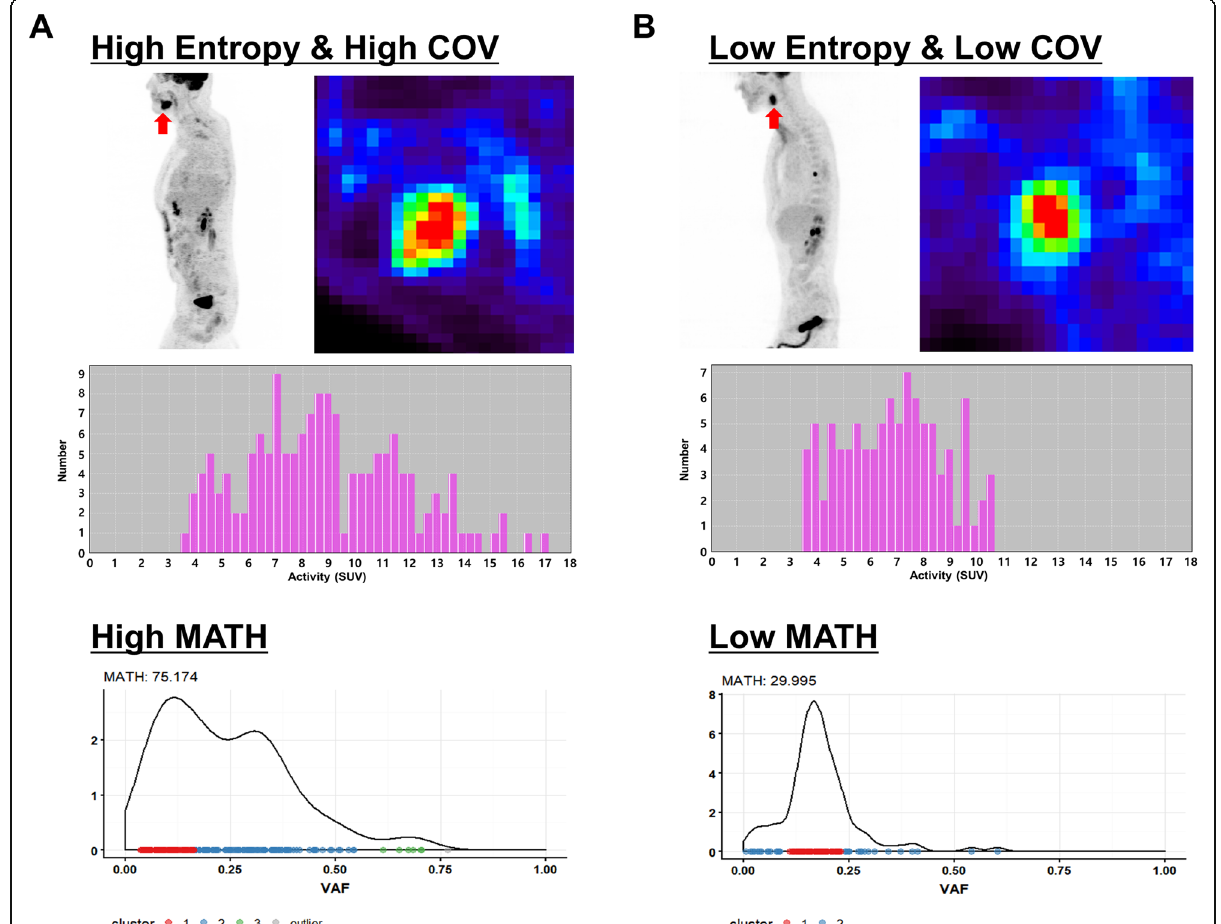
Fig. 4 Representative cases. a A patient had a tongue cancer with high metabolic heterogeneity (high entropy and high COV groups). Genomic analysis of the patient revealed that the tumor had high genetic heterogeneity (high MATH group). b A patient had a left tonsillar cancer with low metabolic heterogeneity (low entropy and low COV group) based on FDG PET. Genomic analysis of the patient revealed that the tumor had low genetic heterogeneity (low MATH group). Of note, low and high entropy, COV, and MATH groups are divided according to the optimized cut-offs obtained by cut-off finder